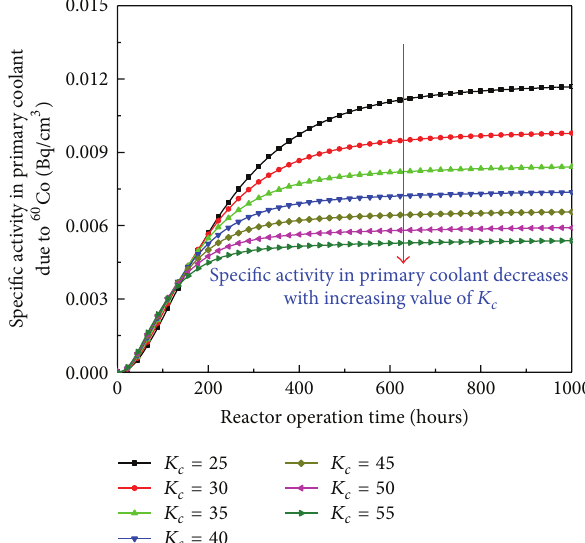
Figure 8: Specific activity of 58 Co on primary coolant piping surfaces of PWR with different values of 𝐾 𝑐